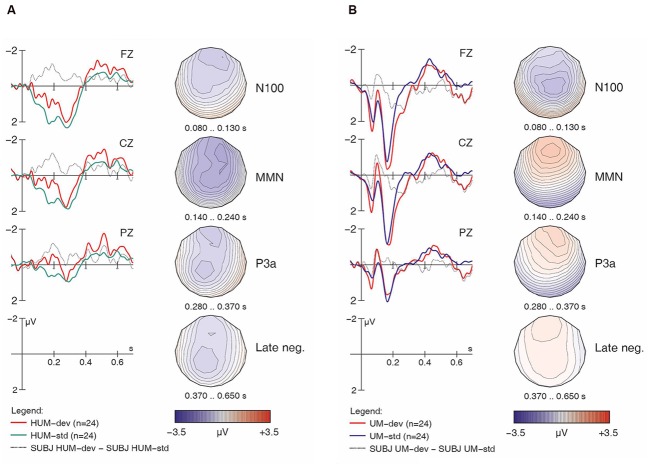
Native English responses to [hᴧm] (A) and [ᴧm] (B) items, both standards and deviants, with difference wave. Negativity is plotted upward; vertical axis at 0 ms indicates stimulus onset.